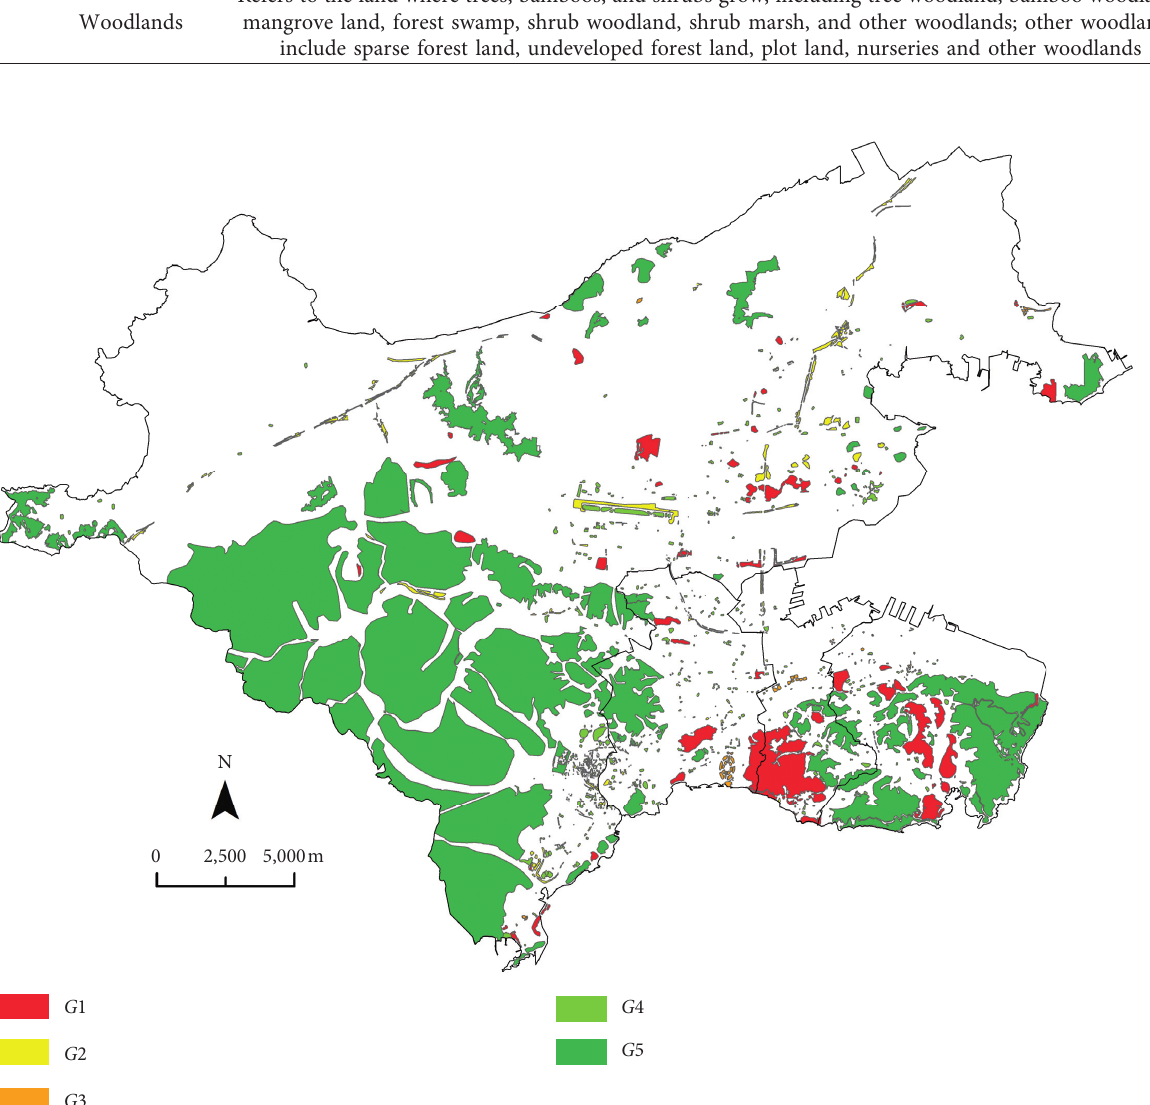
Figure 2: Distribution of green space types in the downtown area of Dalian.